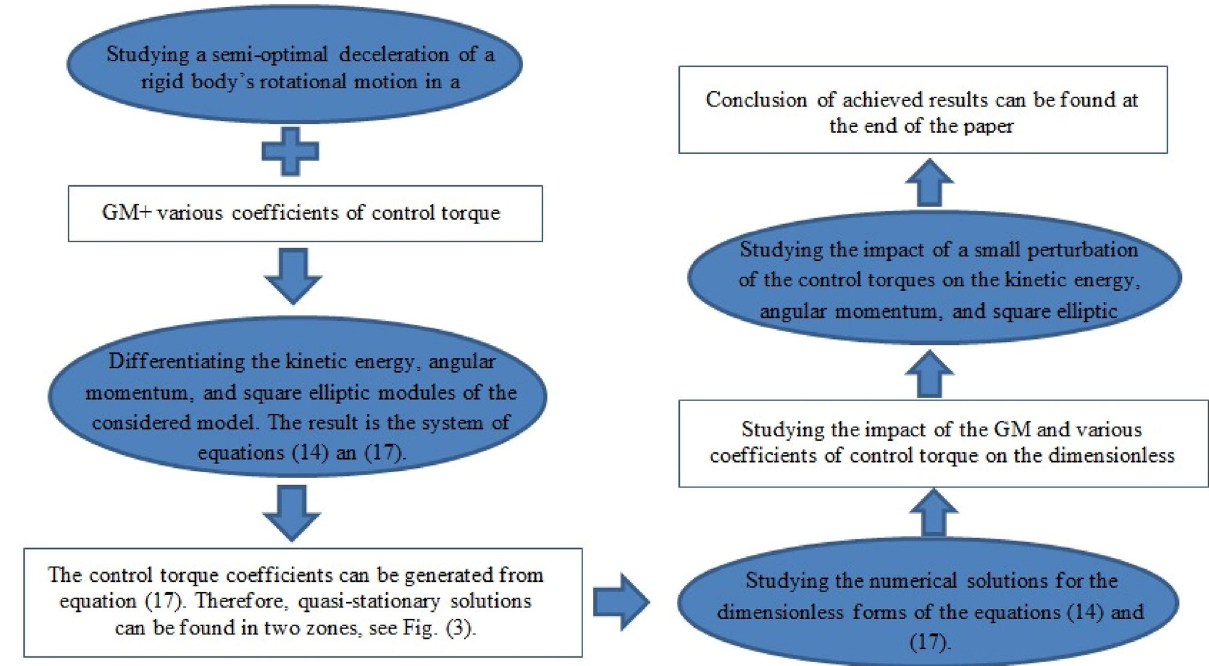
Figure 1. Depicts the controlled system’s